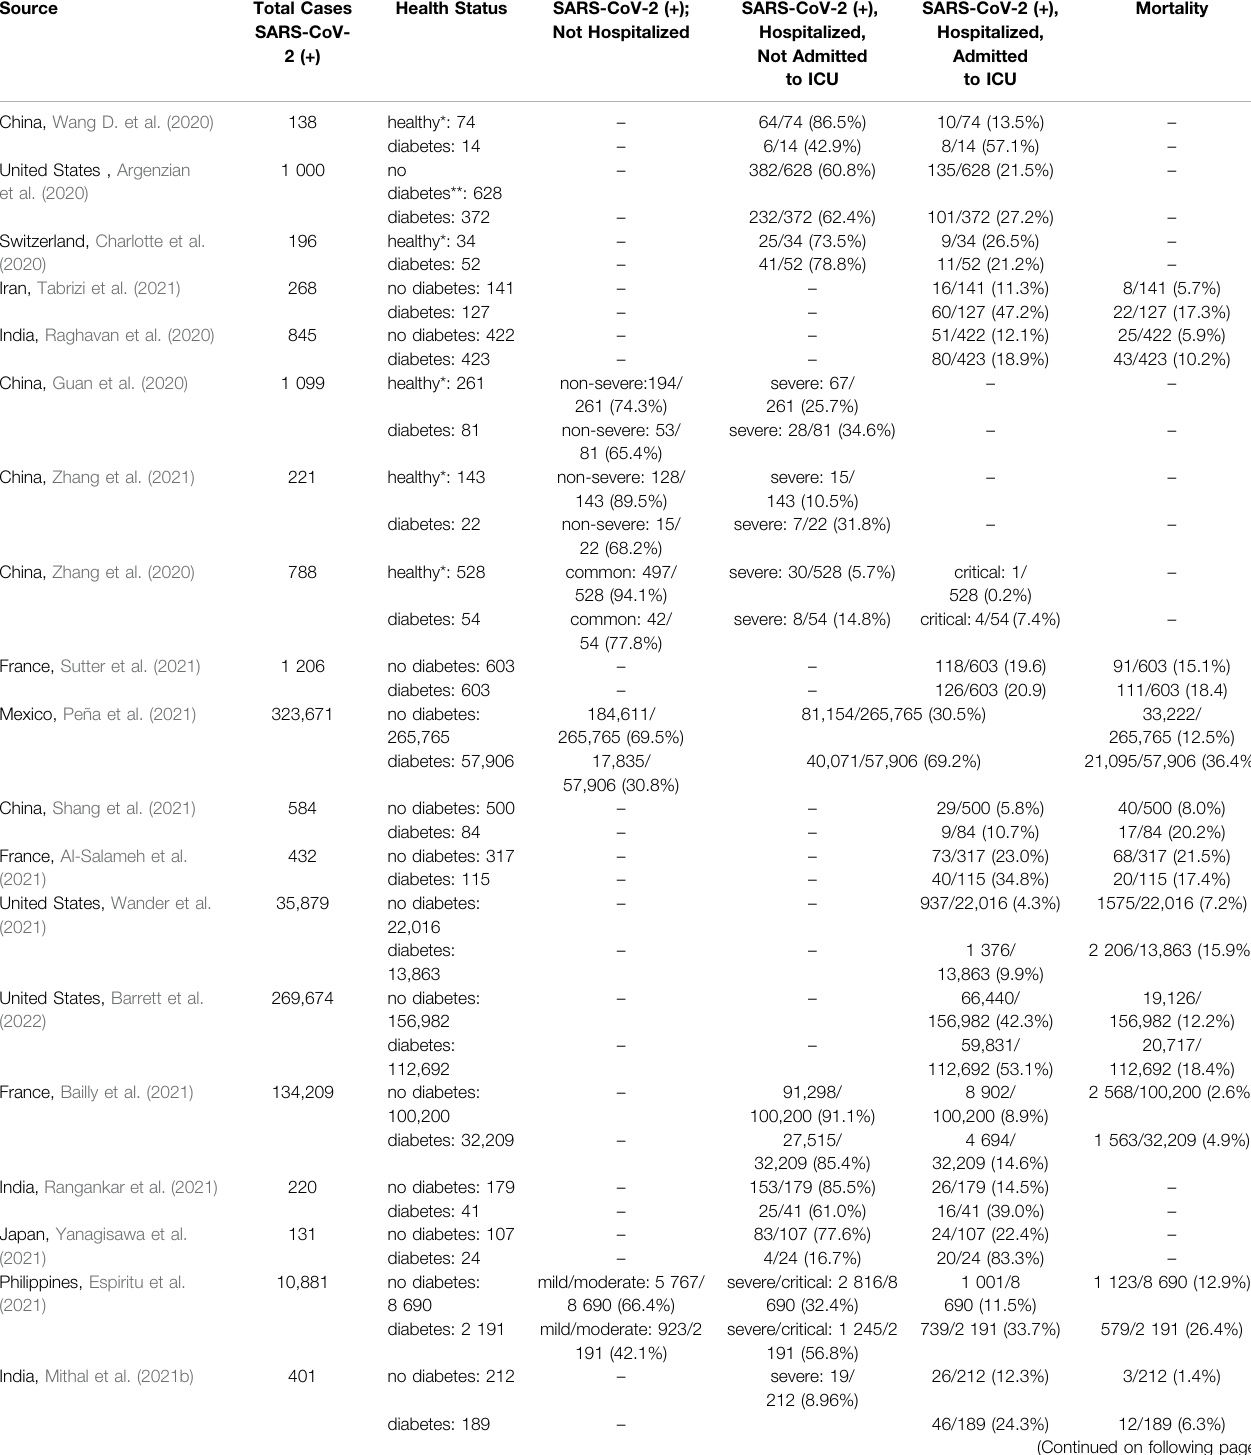
TABLE 1 | ( Continued ) COVID-19 outcome in people with diabetes and control population. Results for diabetic patients were compared to either people without any diagnosed comorbidities ( “ healthy ” ) or people without diabetes, but with unknown status of other comorbidities ( “ no diabetes ” ). Articles containing 1) speci fi ed number of patients examined in the particular study, and 2) a control group (either healthy patients with no comorbidities or non-diabetic patients that could have other comorbidities) allowing a direct comparison with diabetic patients, were included in the table. ICU – intensive care unit; T2D – type 2 diabetes; — no data; * the patients did not show any of the examined comorbidities; ** patients did not have diabetes but might have other